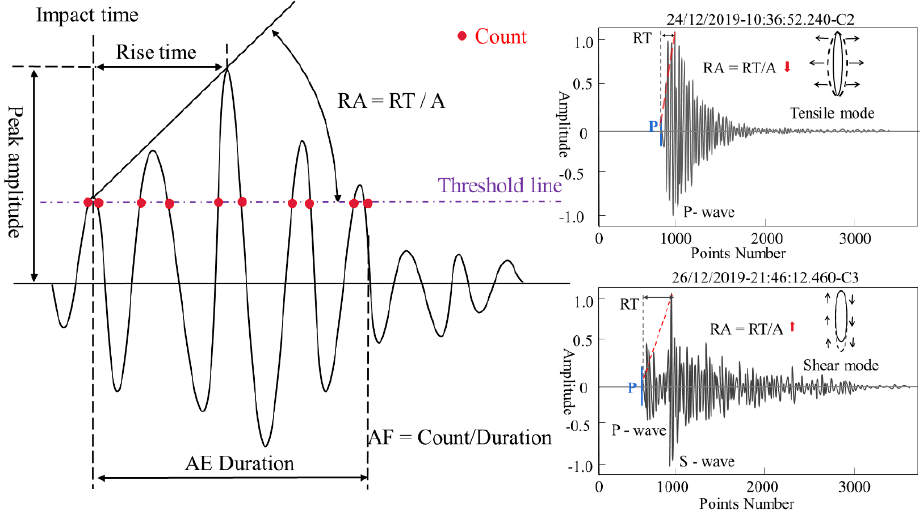
Figure 5. Schematic of hit parameter of AE.